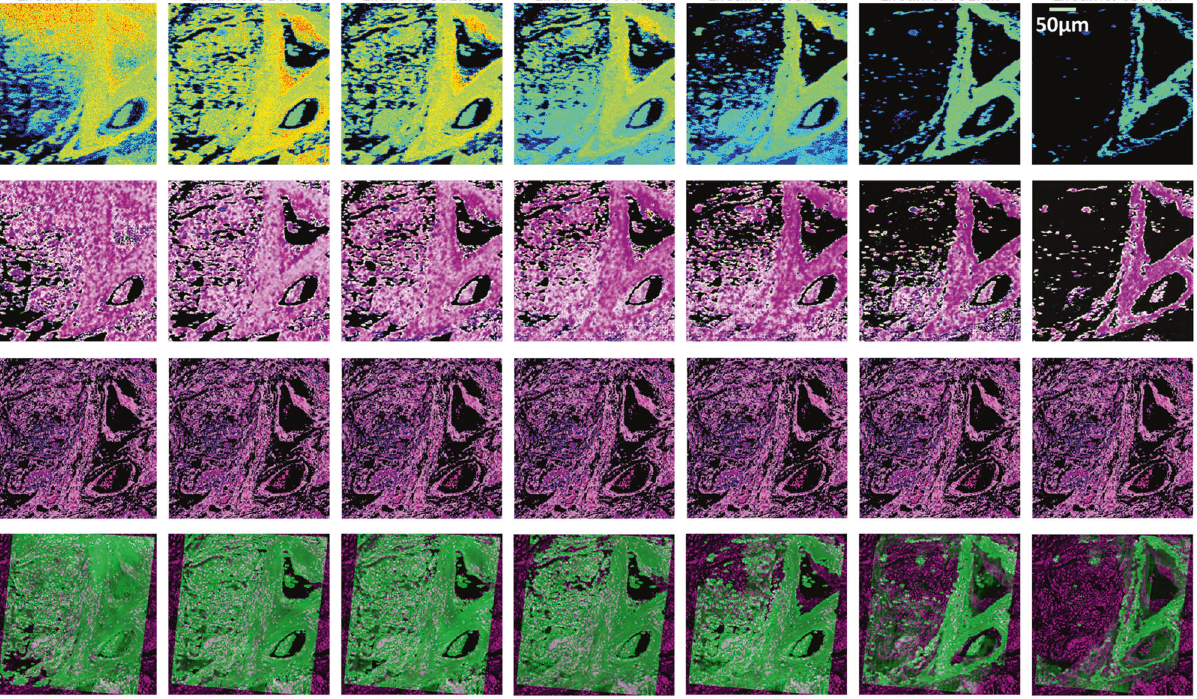
Fig. 4 Registration results based on seven different emission wavelengths. From rows 1 – 4, there are seven spectral lifetime images, the corresponding false histology images, the histology image patch, and the registered images in greyscale generated by blending translated false and real histology images,